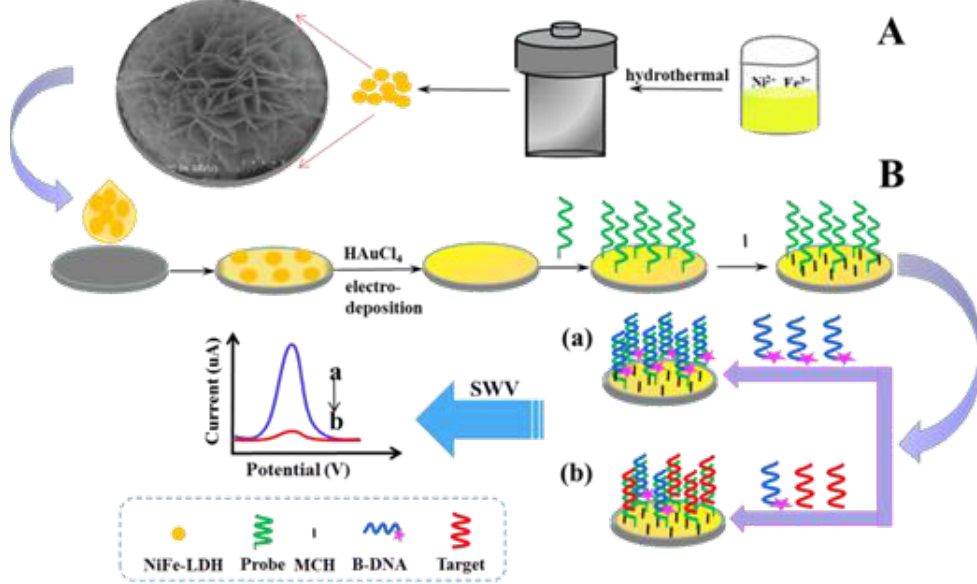
Figure 1. Principle of strand competitive hybridization reaction based on NiFe-LDH for T-DNA electrochemical detection. The process of synthesizing NiFe-LDH ( A ) and the proposed competitive technique ( B ).